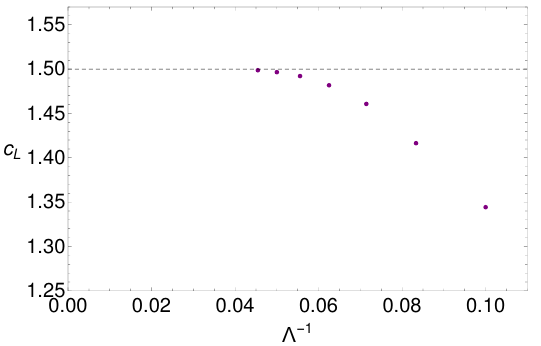
Figure 3 . Lower bound on the allowed left central charge c L (supersymmetric side) of N = (2 ; 0) SCFTs for h = (cid:22) h = 0 : 5 and h gap = (cid:22) h gap = 0 : 8, as a function of the inverse of the number of derivatives ((cid:3) (cid:0) 1 ) to exemplify the convergence of our numerical results with